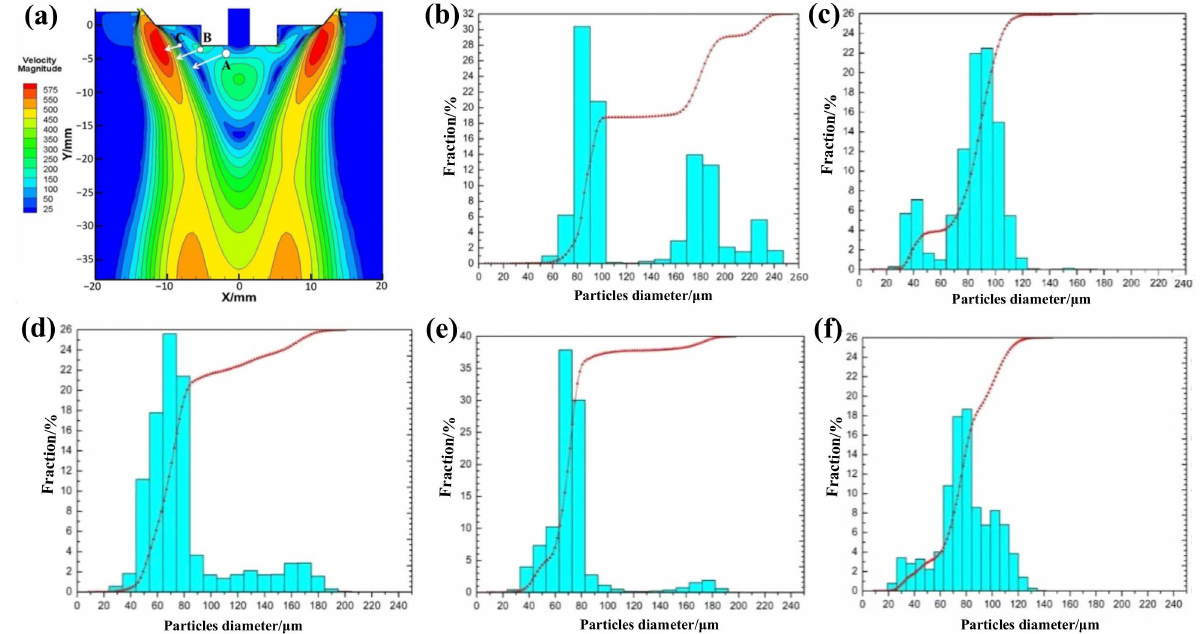
Figure 4. ( a ) Selection of injection source position at an atomization pressure of 5 MPa. ( b – f ) Particle size distribution at different atomization pressures: ( b ) 1 MPa, ( c ) 2 MPa, ( d ) 3 MPa, ( e ) 4 MPa, and ( f ) 5